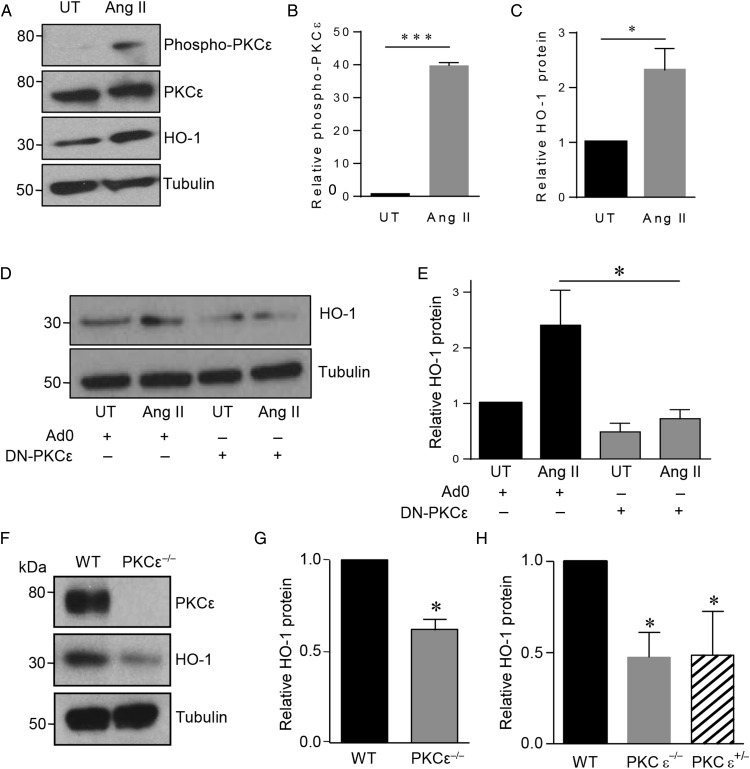
Effect of PKCε activation or depletion on HO-1. (A) HUVECs were treated with vehicle (UT) or angiotensin II (100 nM) (Ang II) for 16 h prior to analysis of PKCε, PKCε(Ser729), and HO-1 by immunoblotting, and quantification by densitometry of: (B) PKCε phosphorylation and (C) HO-1 (n = 3). (D) HUVECs were infected with Ad0 or Ad-DN-PKCε (MOI 100) prior to treatment with vehicle (UT) or Ang II for 16 h and analysis of HO-1 induction by immunoblotting and (E) quantification by densitometry (n = 3). (F) Cardiac ECs from WT and PKCε−/− mice were lysed and immunoblotted for PKCε, HO-1, and tubulin. (G) The histogram shows densitometric quantification of HO-1 (n = 6). (H) Aortas from adult PKCε−/−, PKCε+/− mice, and WT littermate controls (n = 3) were harvested, snap frozen, and subsequently lysed and immunoblotted for HO-1 and tubulin. Data are presented as mean ± SEM, corrected for tubulin expression, and normalized to the untreated or Ad0 control (A–D) and to WT control (G and H) [one-sample t-test (B, C, G, and H), t-test (E), *P < 0.05, ***P < 0.001].